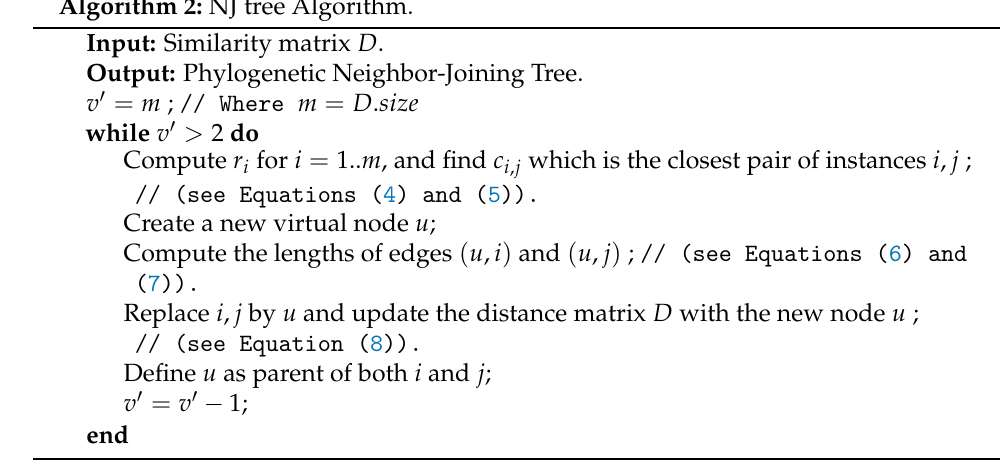
Algorithm 2: NJ tree